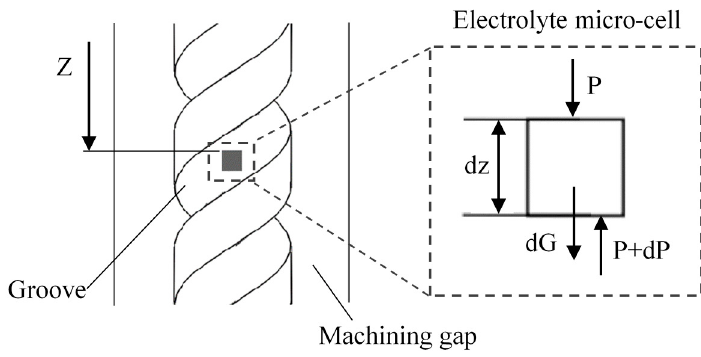
Figure 2. Analysis of the influence of ultrasonic vibration on the electrolyte.